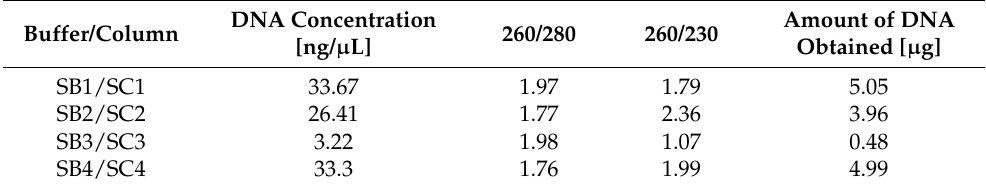
Table 2. DNA concentration and purity determined by spectrophotometric analysis, obtained using Table 1. DNA concentration and purity determined by spectrophotometric analysis, using commer- here developed lysis buffers. cially available DNA purification kits.